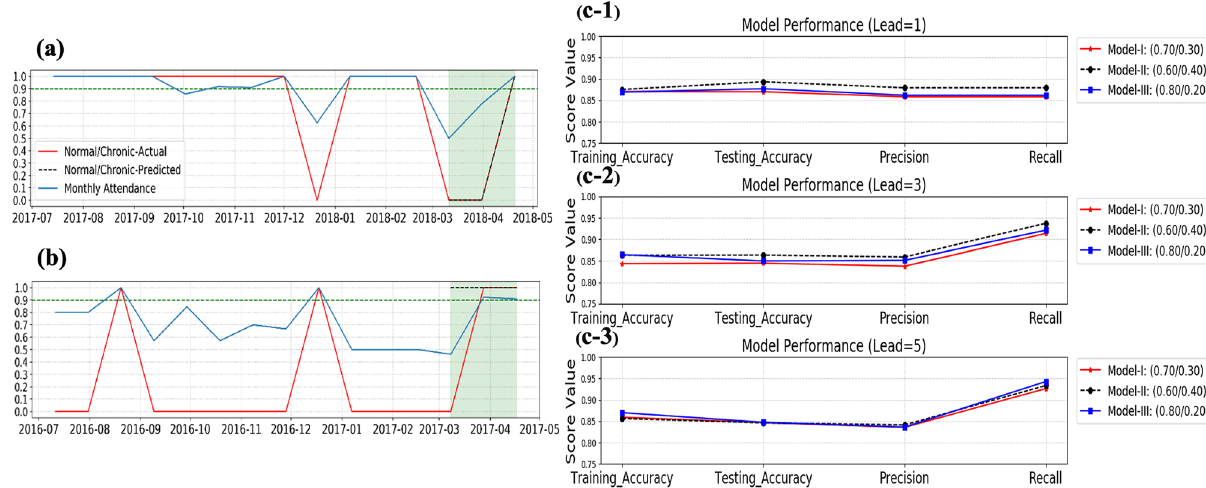
Figure 4. Long-term CA model performance. ( a ) For a student with 100% prediction accuracy ( b ) Another student with 67% prediction accuracy. ( c-1 ) Prediction accuracy for a lead value of one day. ( c-2 ) 3 days lead value. ( c-3 ) 5 days lead value. The best prediction performance achieved by (lead value = 1 ) and (0.70/0.30) train/test validation